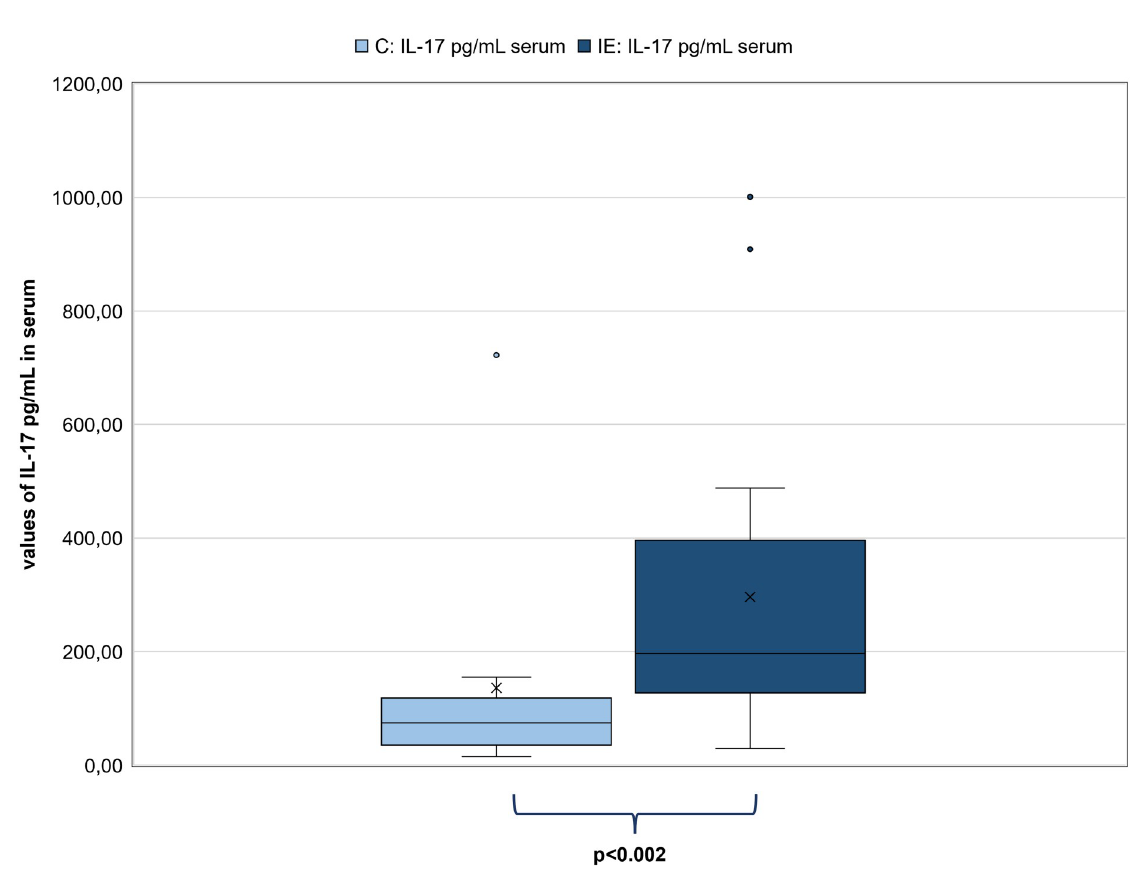
Fig 4. Comparison of the IL-17 values in pg/mL in serum samples between dogs with IE and the control group (C). Left pale blue box plot showing results of IL-17 values of C (n = 10) and the right dark blue box plot showing results of IL-17 values of dogs with IE (n = 33). Both box plots represent the maximum, the third quartile, the mean, the median the first quartile and minimum of measured IL-17 in serum samples (in pg/mL). The IL-17 values of dogs with IE were significantly higher than those of C (p < 0.002). Abbreviations: C: control group; IE: idiopathic